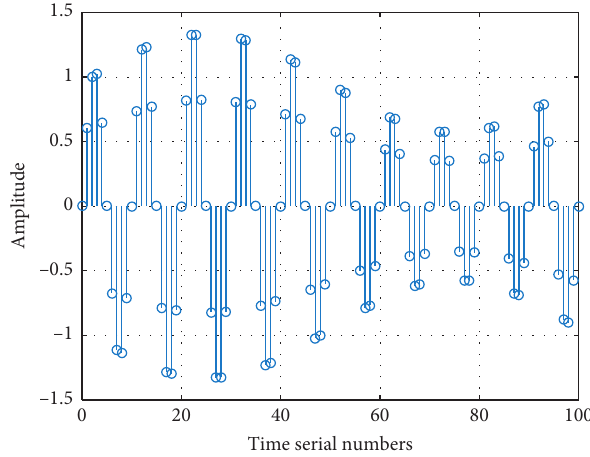
Figure 6: Timing dependence of music signal after deep